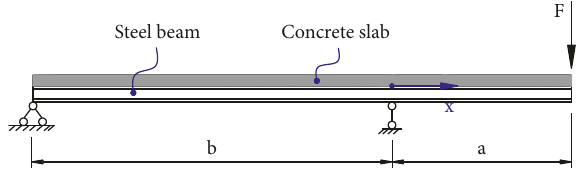
Figure 1: Model of overhanging steel-concrete composite